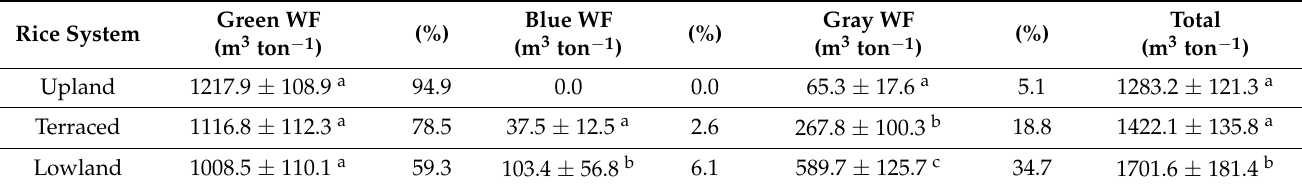
Table 4. Water footprint of the lowland, terraced, and upland rice systems during 2020–2022 (mean ± standard